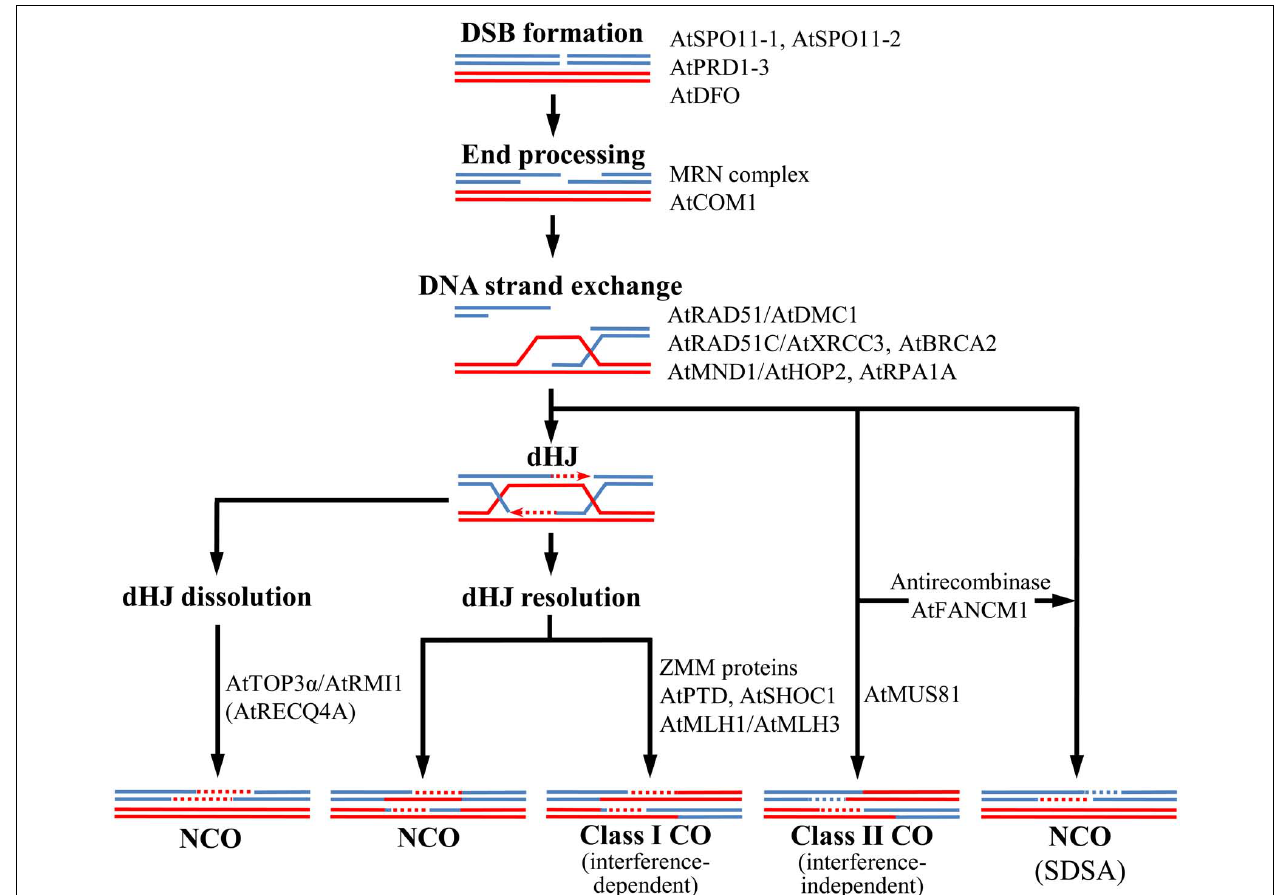
FIGURE 1 | Model for crossover (CO) and non-crossover (NCO) formation in Arabidopsis meiosis. Double-strand breaks (DSBs) are formed and their 5 (cid:2) ends processed to generate 3 (cid:2) -ended single-stranded DNA (ssDNA). One of these ends invades the homologous duplex DNA, giving raise a D loop intermediate. If the second end is captured and the broken DNA strands are ligated, a double Holliday junction (dHJ) is formed. This dHJ can be dissolved as a NCO or resolved to form either a NCO or a